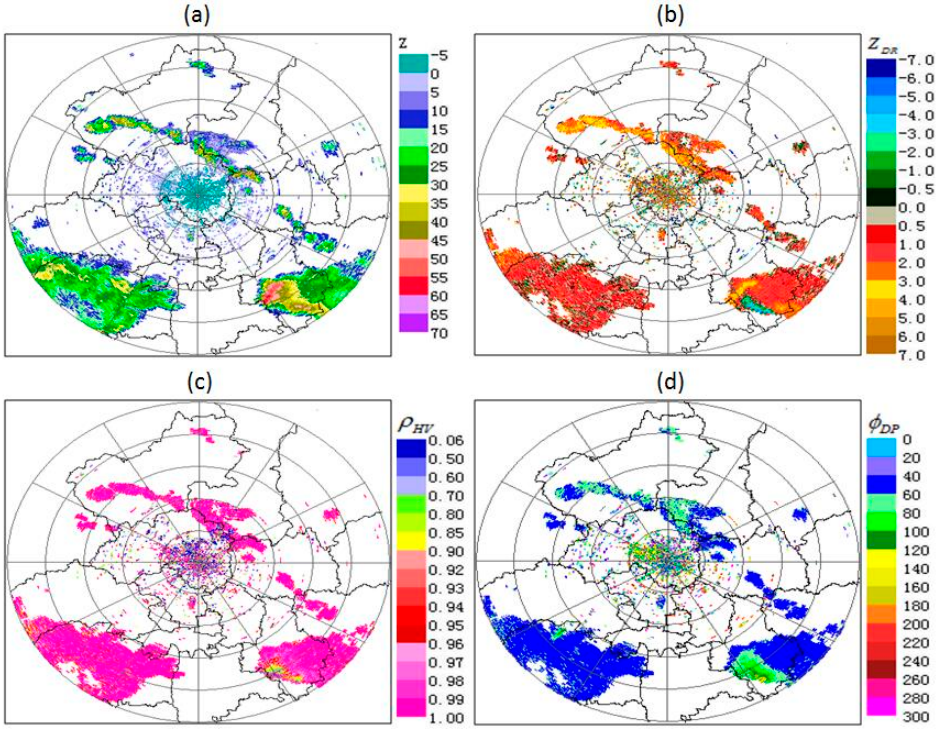
Figure 4. The parameters of ( a ) Z, ( b ) Z DR , ( c ) ρ HV , ( d ) Φ DP from Changping radar, 1.5° PPIs, at 08:00 (UTC) 2 July 2019.